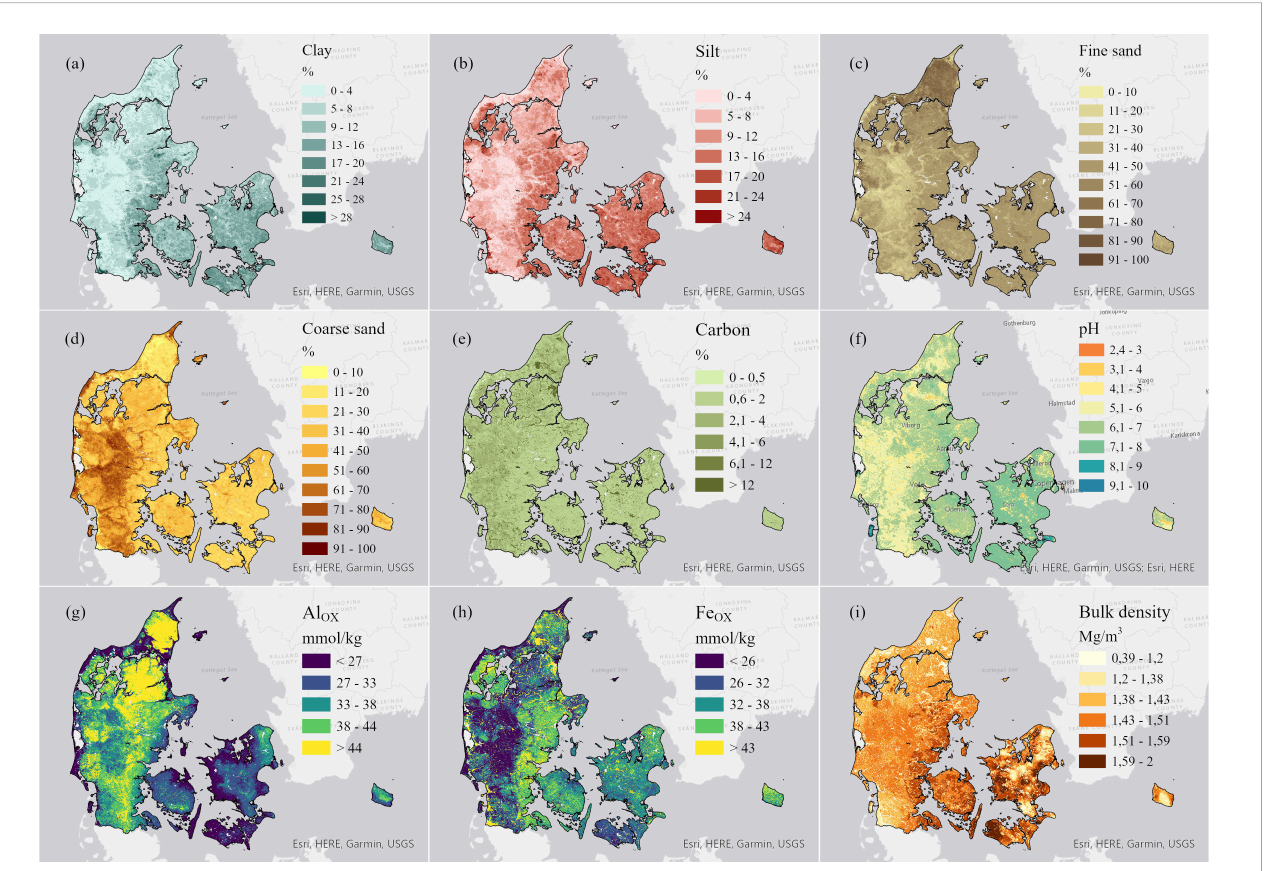
FIGURE 3 Maps of soil properties for Denmark for the topsoil layer: (A) clay, (B) silt, (C) fi ne sand, (D) coarse sand, (E) soil organic carbon content, (F) soil pH, (G) oxalate-extractable aluminium, (H) oxalate-extractable iron, (I) soil bulk